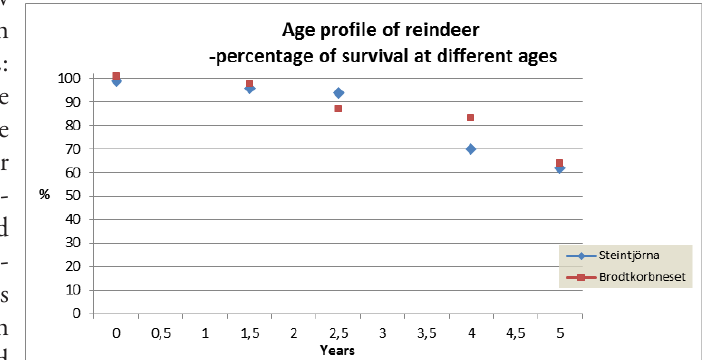
Figure 6. Kill off rate of reindeer, based on data in tab. 6. At 5 years there is a survival percentage of a little more than 60 %. Consequently only 40% of the reindeer turned out to be less than 5 years when